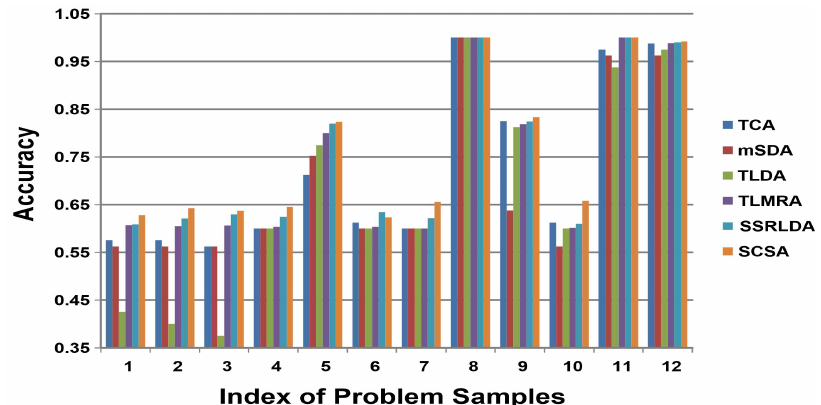
Figure 3. Performances on Leaves dataset. The y-axis represents the classification accuracy of target domain; the x-axis represents the index of the problem